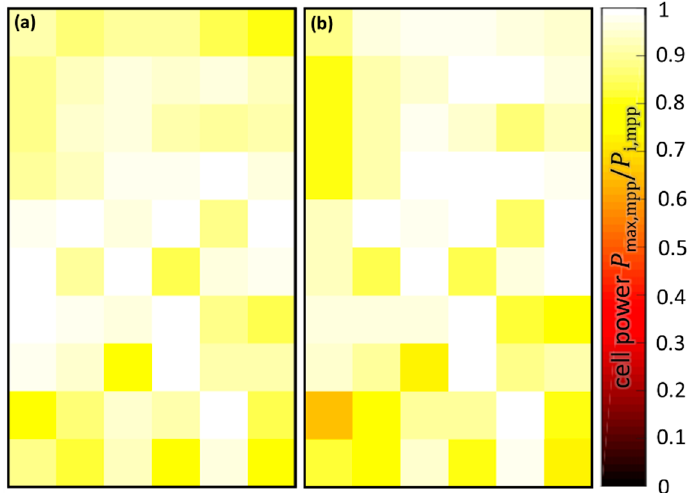
Figure 7. Measured maximal power output ( a ) and simulated maximal power output ( b ) for all individual cells. All cell powers were normalized according to the maximal measured or simulated cell power in the module and colored by the same false color scale. The location of defective cells and the normalized cell power was in good agreement comparing simulation and measurement.